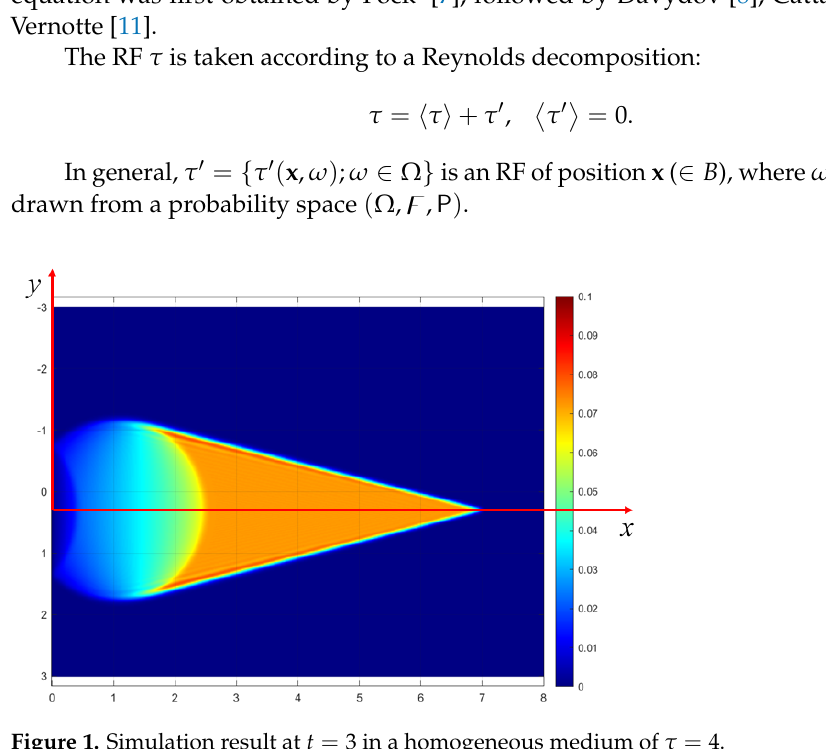
Figure 1. Simulation result at t = 3 in a homogeneous medium of τ =